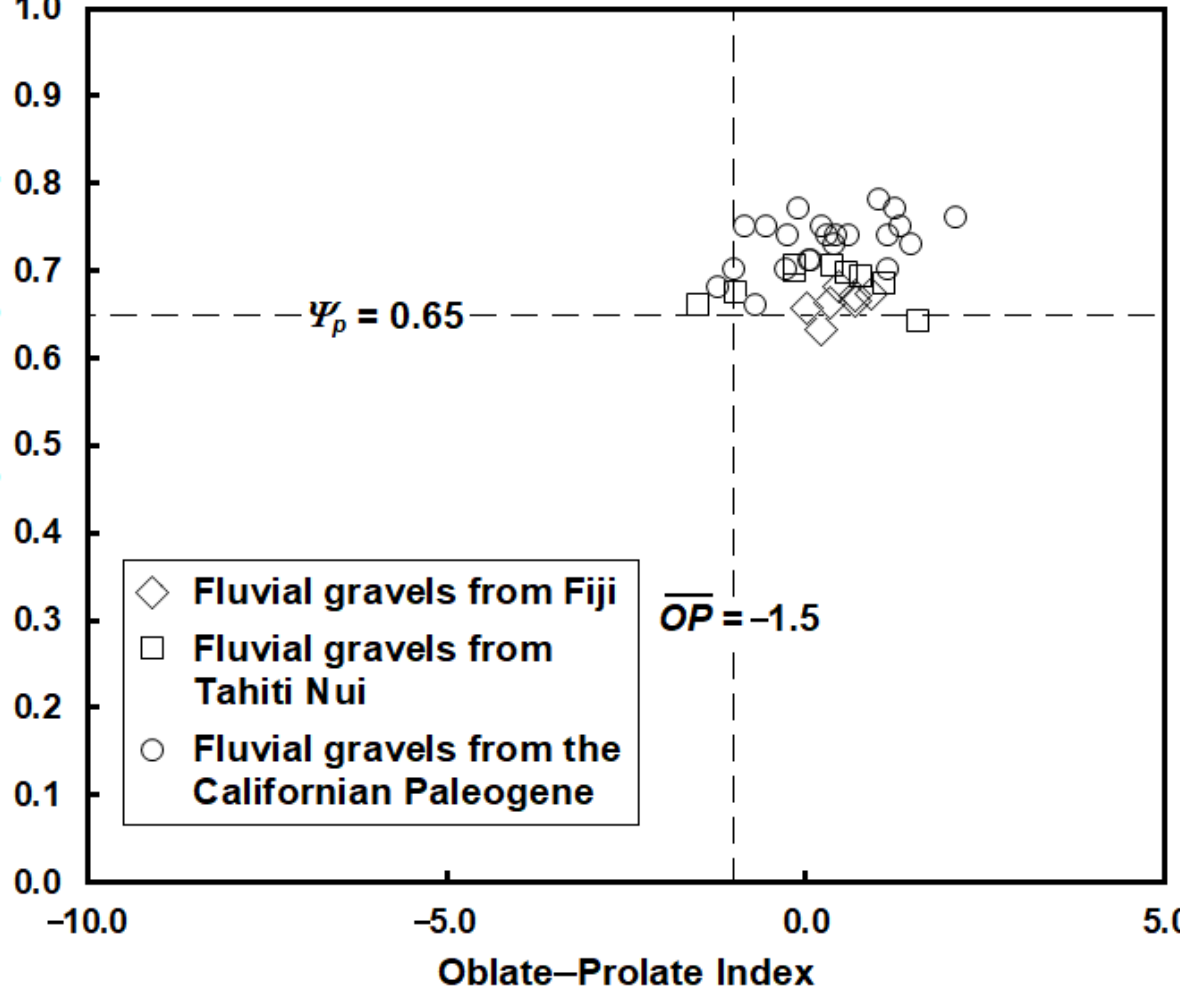
Figure 20. The mean Oblate–Prolate Index and mean Maximum Projection Sphericity of fluvial gravels from Tahiti Nui [15], Californian Paleogene deposits [51] and the Sabeto River, Fiji (this study).